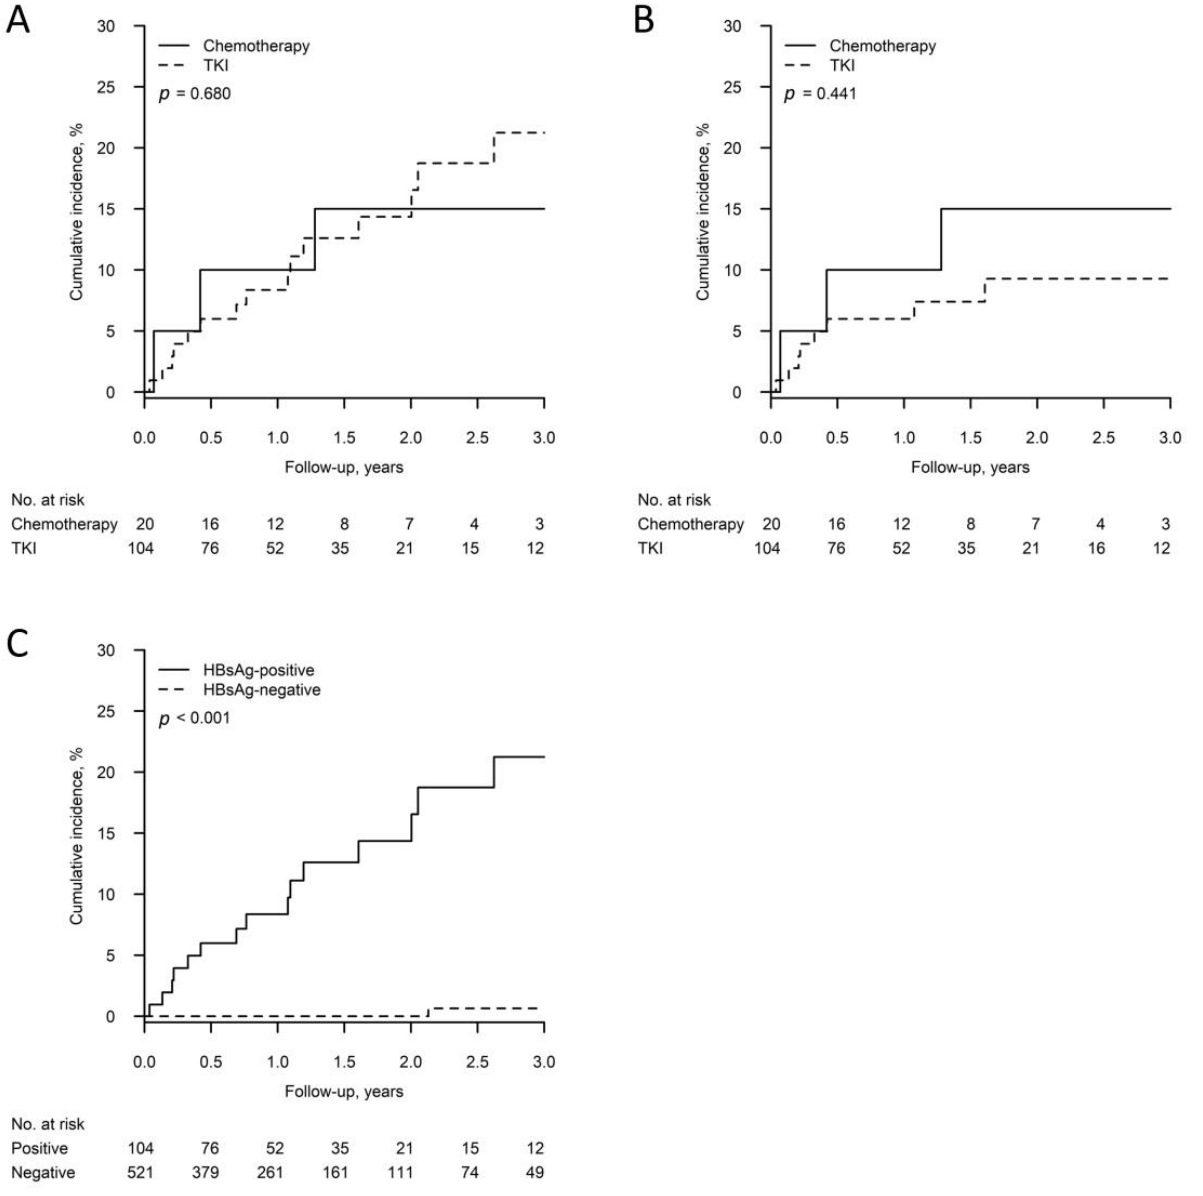
Figure 2. ( A ) Cumulative incidence of HBV reactivation in HBsAg-positive patients without pro- phylactic NUC who received chemotherapy or tyrosine kinase inhibitor (TKI). ( B ) Comparison of cumulative HBV-related hepatitis incidence between HBsAg-positive patients without prophylactic NUC receiving chemotherapy and TKI. ( C ) Comparison of cumulative HBV reactivation incidence in patients receiving first-line TKI without prophylactic NUC between HBsAg-positive and HBsAg-negative groups. TKI, tyrosine kinase inhibitor.